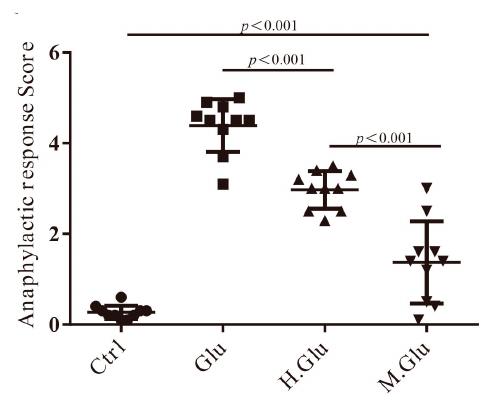
Figure 2. Hypersensitivity symptom scores of mice. Mice sensitization with MGO-glutenin showed a low hypersensitivity reaction (all scores ≤ 1). BALB/c mice were treated with normal saline (control group), glutenin, heated glutenin, and heated MGO-glutenin. Ctrl represents the control group and Glu, H.Glu, and M.Glu represent native glutenin, heated glutenin, and MGO-glutenin, respectively. The triangle represents the control group, the square represents native glutenin, the upward triangle represents heated glutenin, and the downward triangle represents MGO-glutenin.